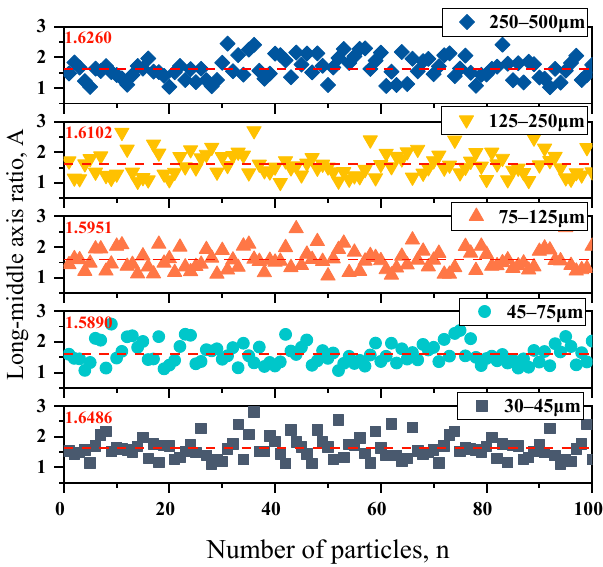
Figure 2. Statistical analysis of the quartz particles’ long–middle axis ratios. The test sample of each particle size range was continuously and uniformly shrunk to 500 particles. The number of images taken by SEM was more than one and contained all 500 particle morphologies. The statistical analysis of 100 particle morphologies ac ‐ counted for 20% of the SEM images, so the samples are representative. Based on what is reported in the statistical analysis chart, the ratio of the long–middle axes of 30–500 μ m block ‐ shaped particles.